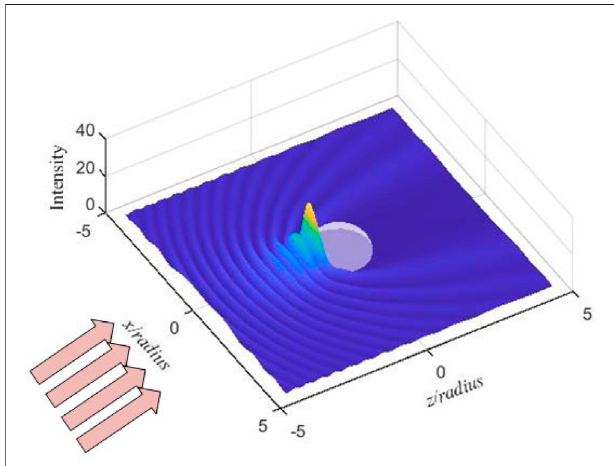
FIGURE10| Thethree-dimensional intensitypattern ofaplasmasphere at f i = 2.1 GHz, f p = 2 GHz, and ] c = 6 GHz.